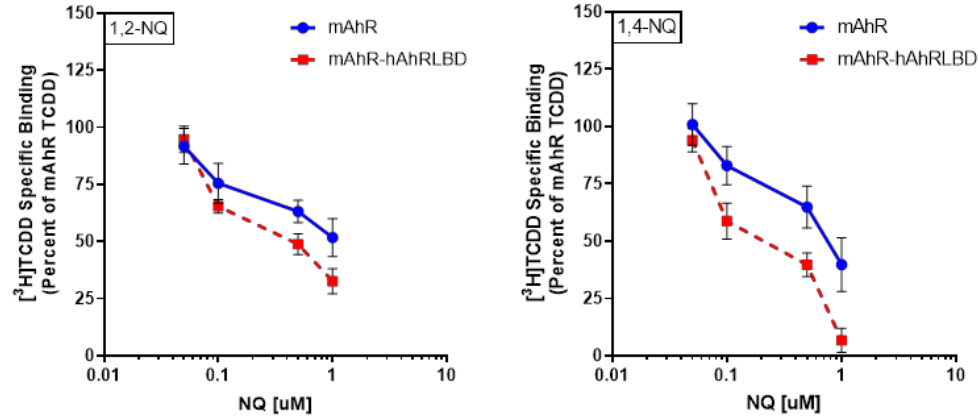
Figure 5. 1,2-NQ and 1,4-NQ competitively bind to the human and mouse AhR ligand binding domain. In vitro synthesized mAhR or mAhR-hAhRLBD was incubated with 20 nM [ 3 H]TCDD in the absence or presence of 1,2-NQ (50 nM – 1 μ M) (red) or 1,4-NQ (50 nM – 1 μ M) (blue) for 30 min, and [ 3 H]TCDD bound to the protein fraction was measured by the hydroxyapatite binding assay. Unprogrammed lysate was used as a nonspecific binding control, and specific binding was calculated as the difference between the amount of [ 3 H]TCDD bound in the total and nonspecific reactions. Values were normalized to the total specific binding of [ 3 H]TCDD in the absence of competitor (set at 100%) and values represent the mean ± standard deviation of triplicate analyses of three incubations and are representative of three individual